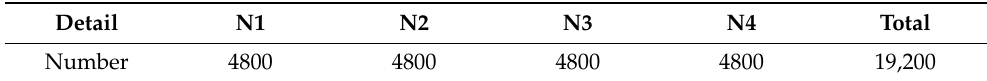
Table 5. Number of samples for feature visualization.